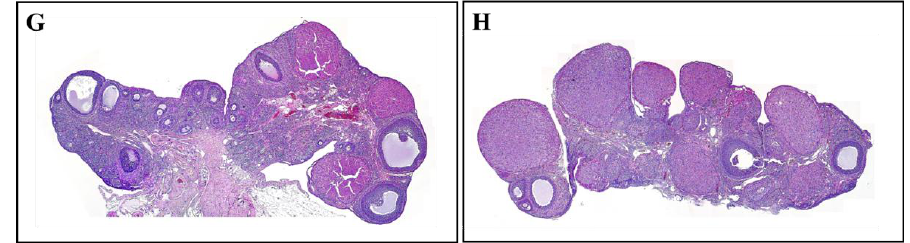
Figure 2. Effects of VCD and parabens on folliculogenesis in rat ovaries. The ovaries section were hematoxylin & eosin (H&E) stained for histological analysis. ( A ) vehicle; ( B ) VCD; ( C ) MP; ( D ) VCD + MP; ( E ) PP; ( F ) VCD + PP; ( G ) BP; ( H ) VCD + BP. VE 20% Et-OH, VCD 40 mg/kg/day, MP, PP, BP 100 mg/kg/day.